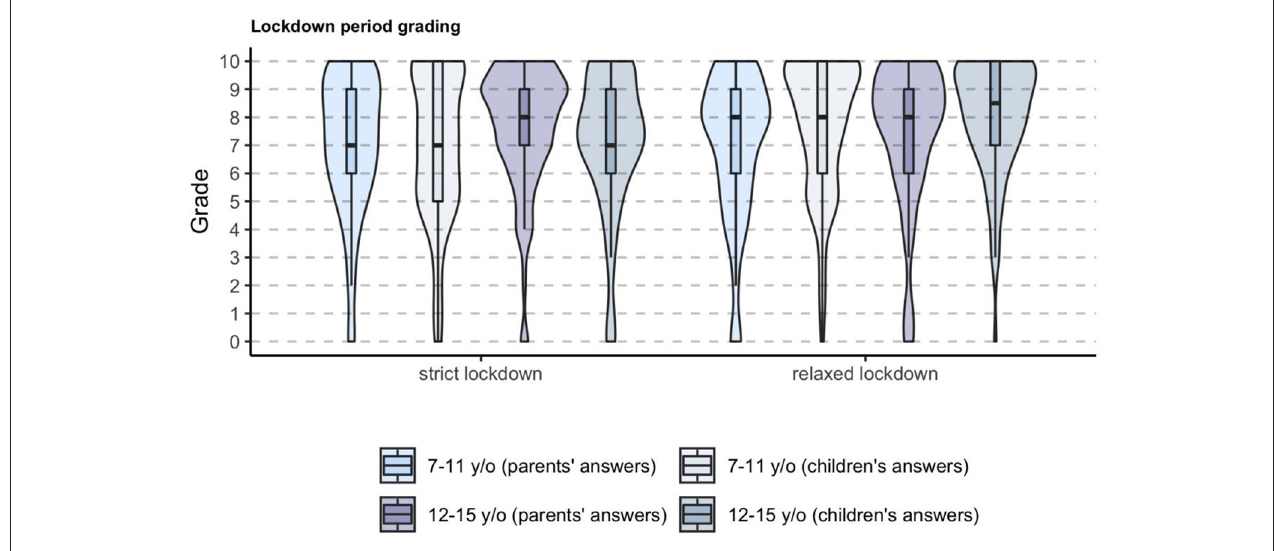
FIGURE 1 | Overall coping with strict and relaxed lockdown according to parents and to children and